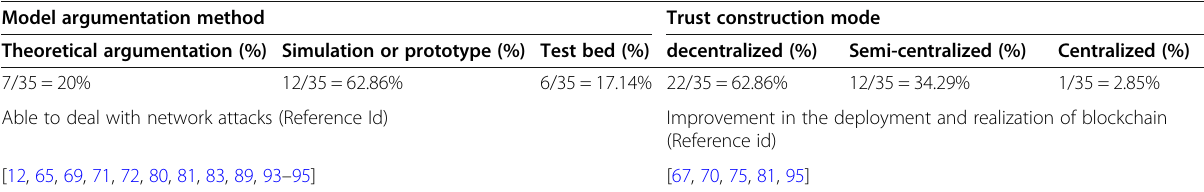
Table 10 The summary of the comparisons Model argumentation